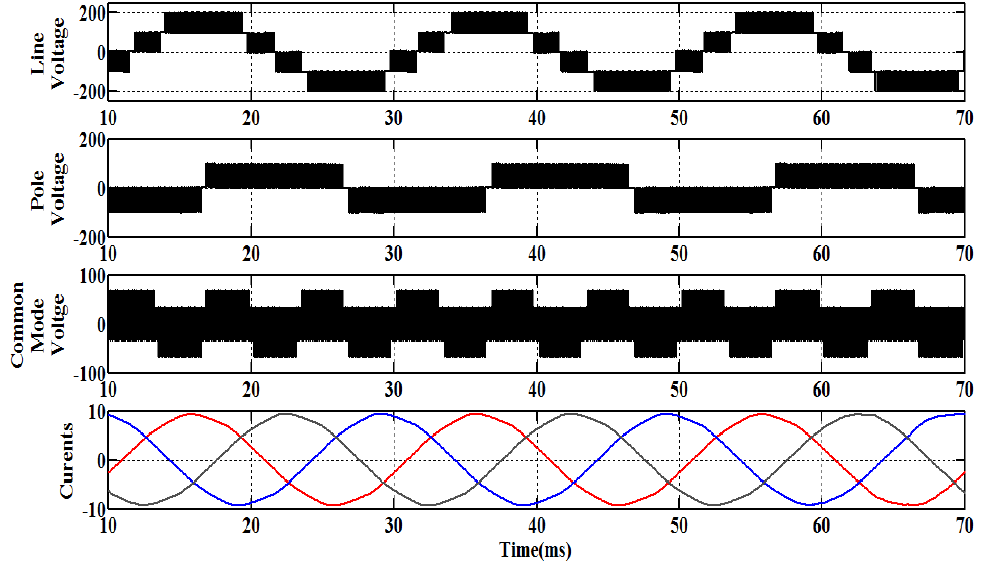
Figure 11. Simulated output waveforms of the transistor clamped VSI, as shown in Figure 1, at a carrier frequency of 5.5 kHz, with a modulation index of 0.9.